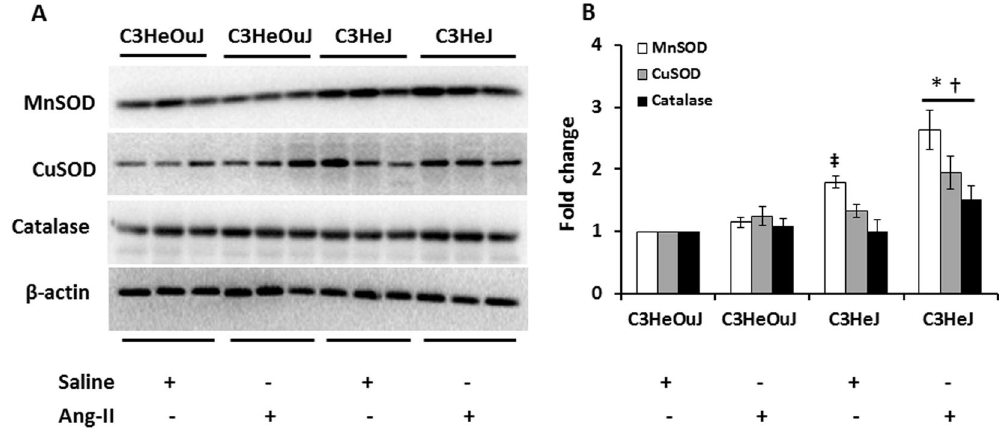
Figure 6. The expression of MnSOD, CuSOD and Catalase is upregulated in Ang-II treated TLR4 deficiency mice. ( A ) Fifty micrograms of protein from each group were separated on SDS-PAGE and incubated with appropriate antibodies overnight. ( B ) Data was normalized to β -actin and are presented as mean ± SEM. * p < 0.05 vs. C3H/HeJ + Saline, † p < 0.05 vs. C3H/HeOuJ groups. n =